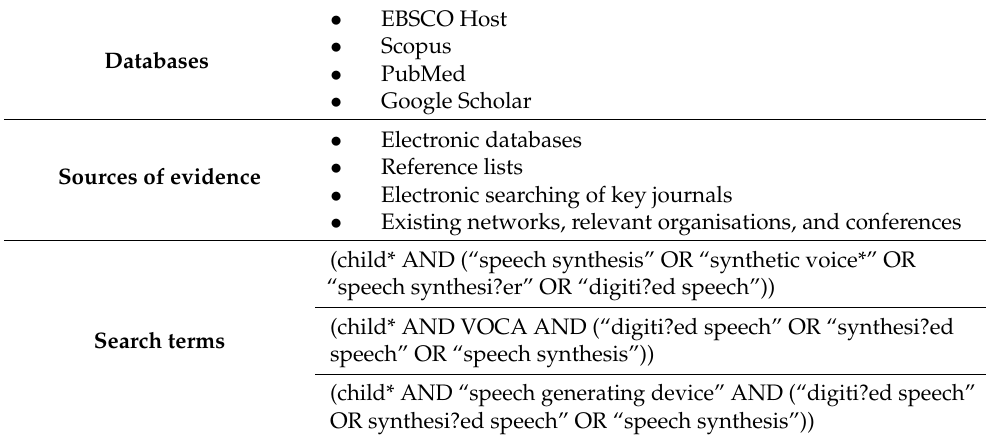
Table 1. The search procedures used in the scoping